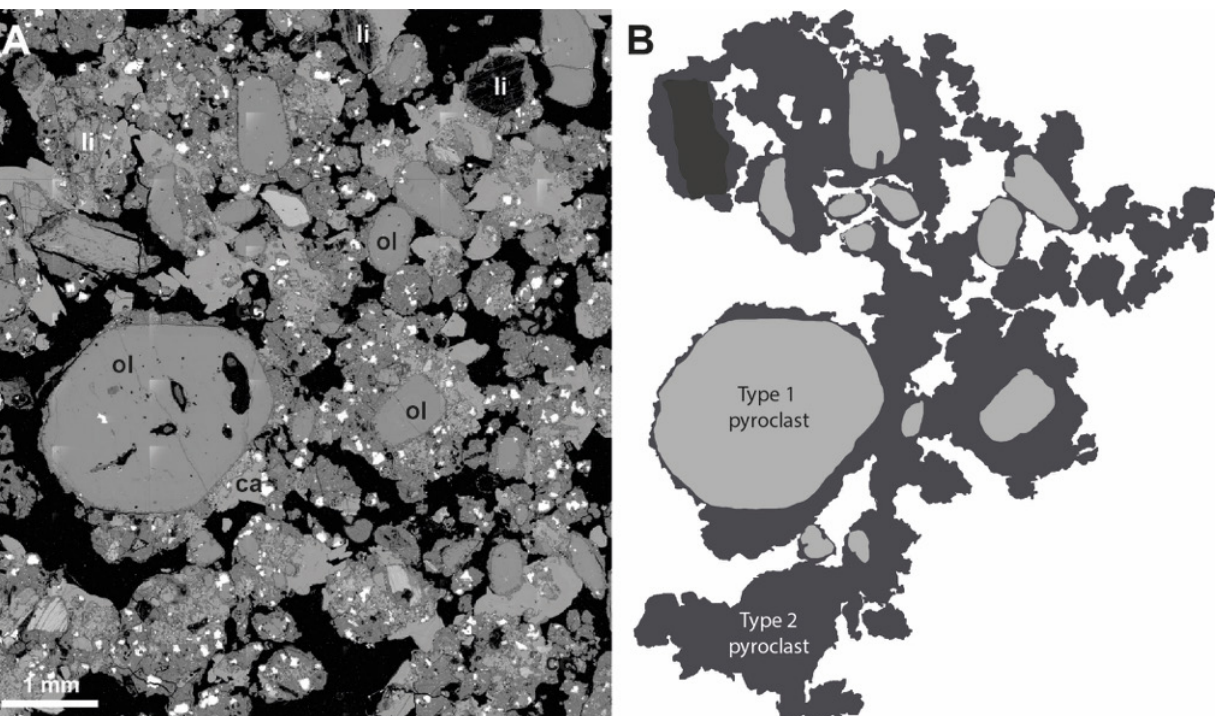
Figure 3: Typical features of agglutinated pyroclasts. [A] BSE image of large agglutinate within the studied tephra fall deposit. Pore space is black in the image. ol = olivine; ca = calcite cement; li = lithic clasts or lithic- derived crystals [B] Outline of agglutinate in A showing pyroclasts consisting of large olivine crystals (grey) and crystallised juvenile melt (dark